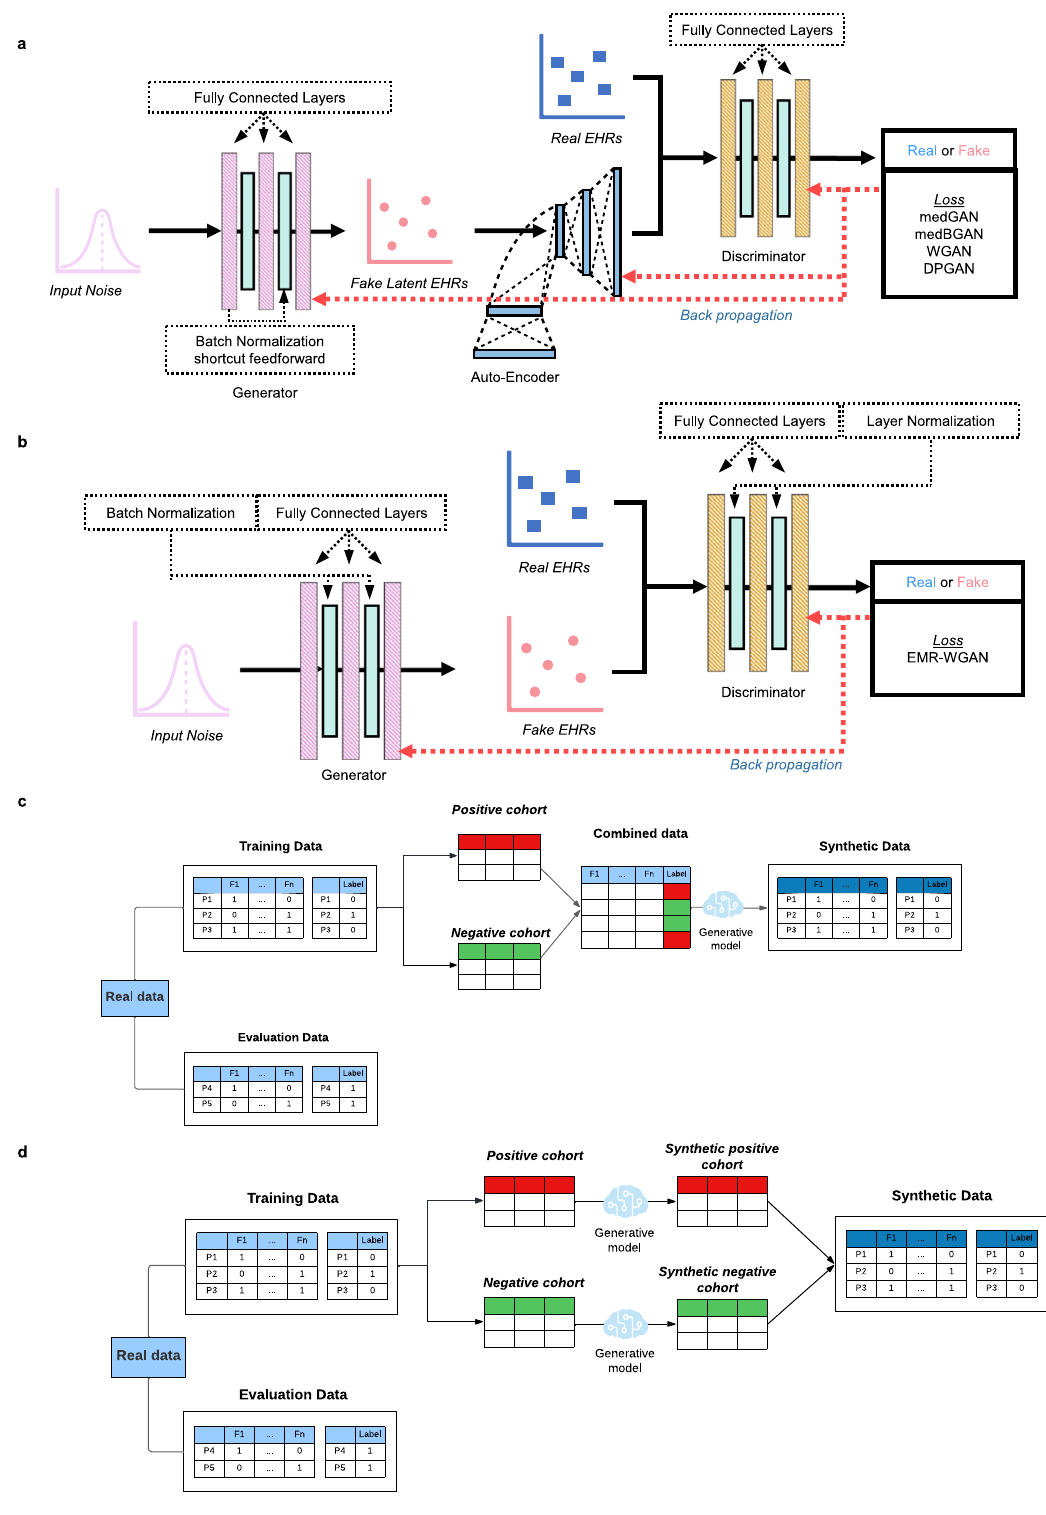
Fig.6|Anarchitecturaldepictionofthedeepgenerativemodelsandsynthesisparadigmsconsideredinthisstudy.a ThegenerativemodelarchitectureofmedGAN, medBGAN, WGAN, and DPGAN. b The generative model architecture of EMR-WGAN. c Combined synthesis paradigm. d Separated synthesis